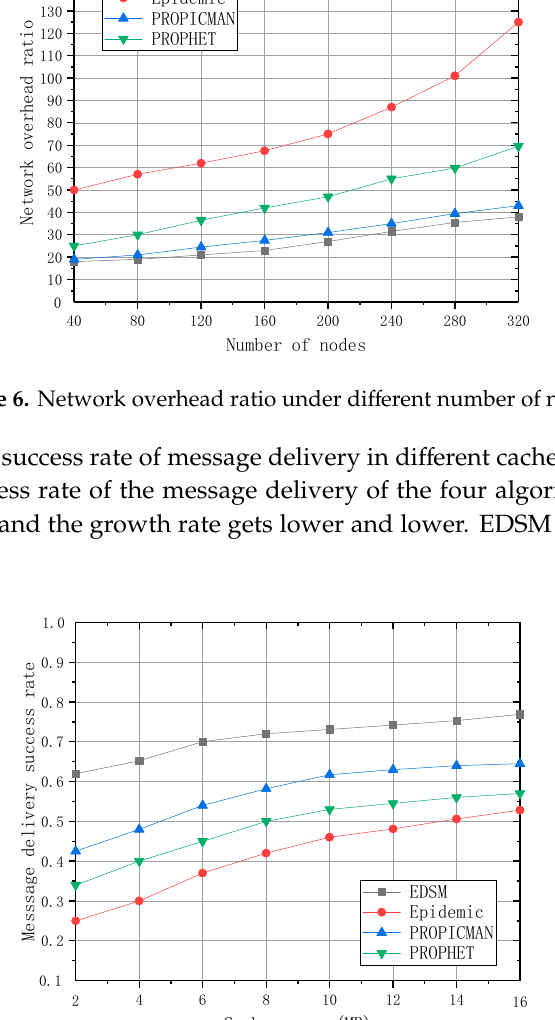
Figure 5. Average message delay under a different number of nodes.